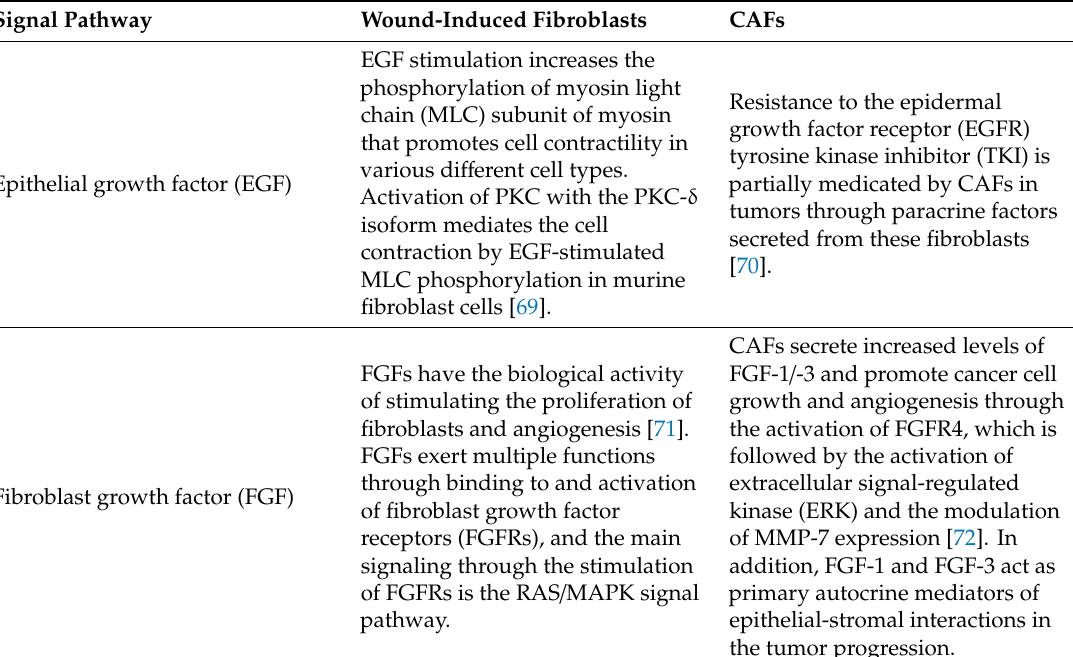
Table 1. The critical signal pathways activated in both wound-induced fibroblasts and CAFs. Signal